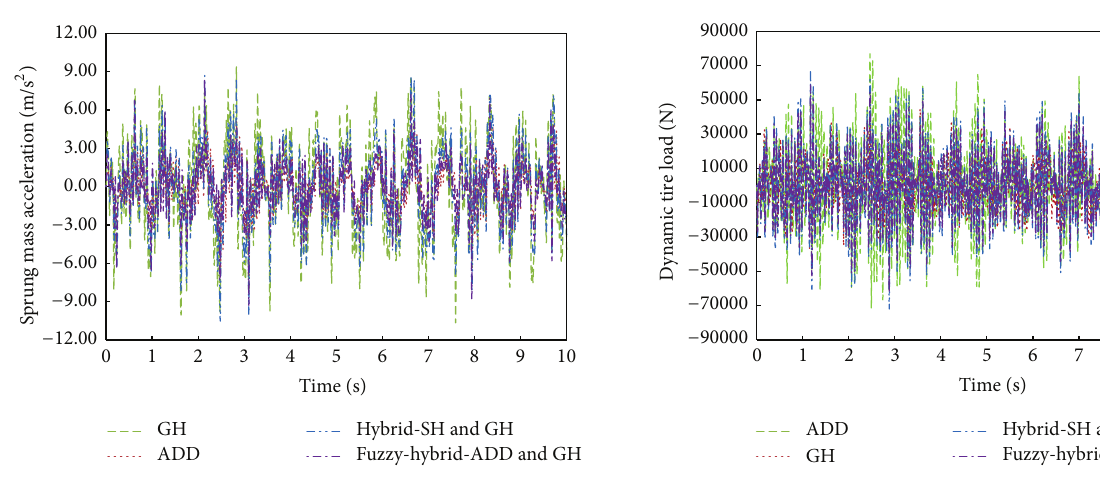
Figure 9: Comparison of sprung mass acceleration. Figure 10: Comparison of dynamic tire